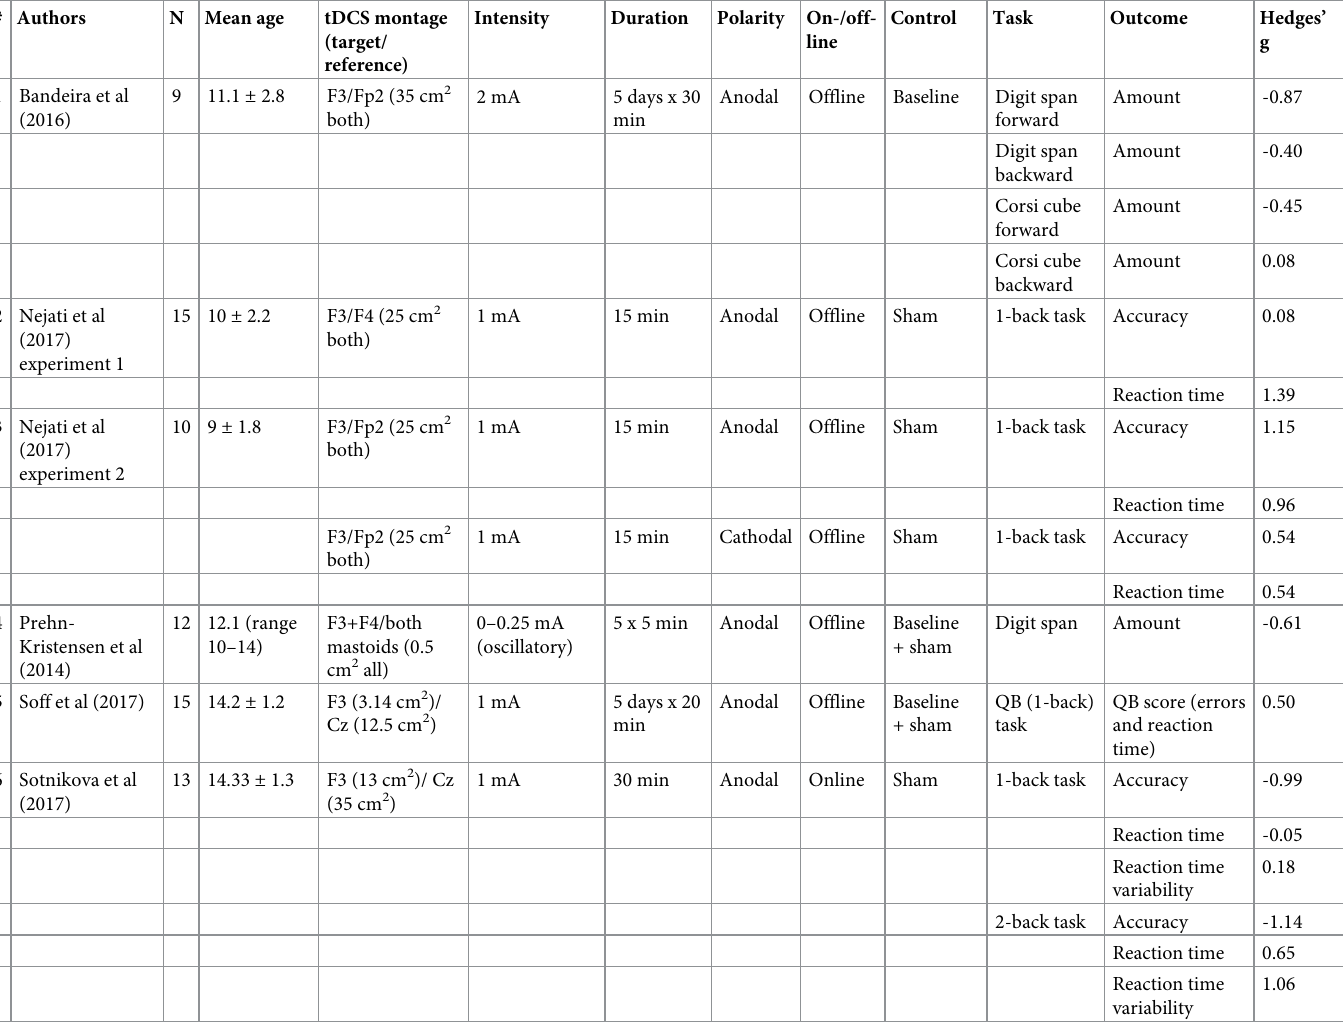
Table 2. Characteristic of studies included in the meta-analysis for the effects of tDCS on working memory.